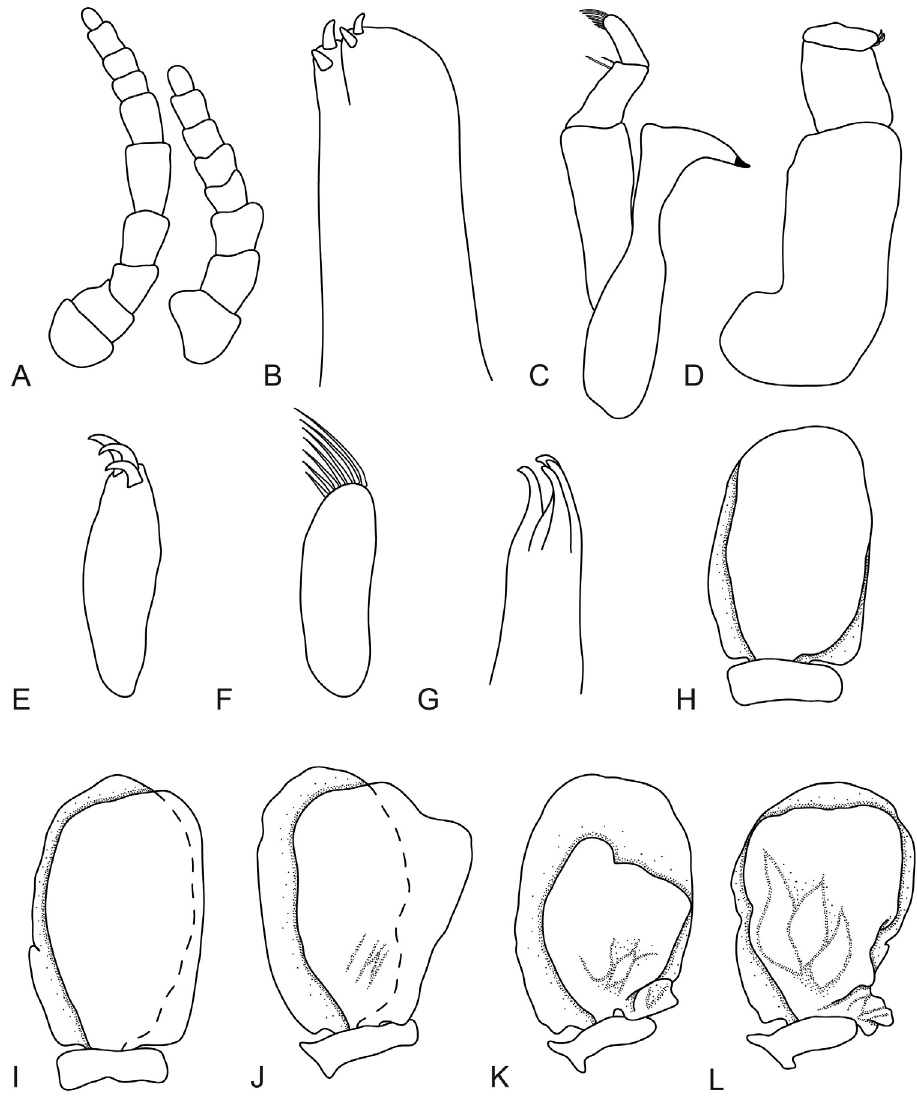
Figure 8. Anilocra brillae sp. n . transitional stage (11 mm): A antenna (left) and antennula (right) B maxilla C mandible D maxilliped E article 3 of maxilliped F article 3 of mandibular palp G maxillule H–K pleopods 1–5